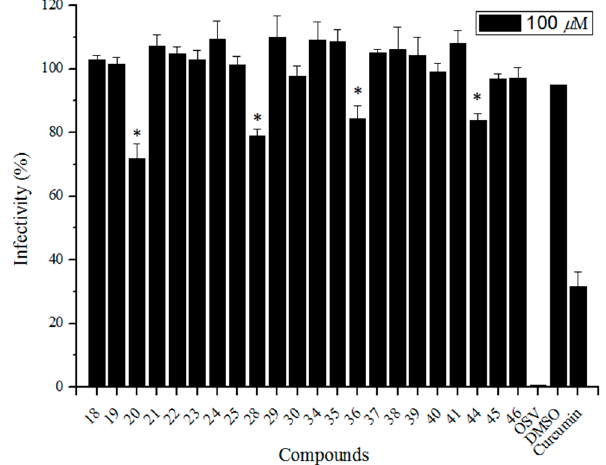
Figure 3. The cytopathic effect-based screening of conjugated sialic acid and pentacyclic triterpene derivatives. The Madin-Darby canine kidney (MDCK) was utilized as the host cell to test the A/WSN/33 virus infection; 0.5% DMSO (final concentration) was used as the negative control; curcumin (a small-molecule entry inhibitor targeting the HA1 domain) as well as OSV (oseltamivir) were utilized as positive controls. Error bars indicate standard deviations of triplicate experiments. * compared with negative control, p < 0.05.